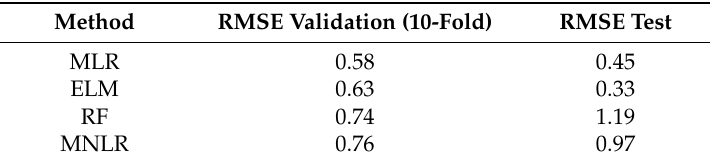
Table 6. Predicted values and the RMSE of the test samples for each method.